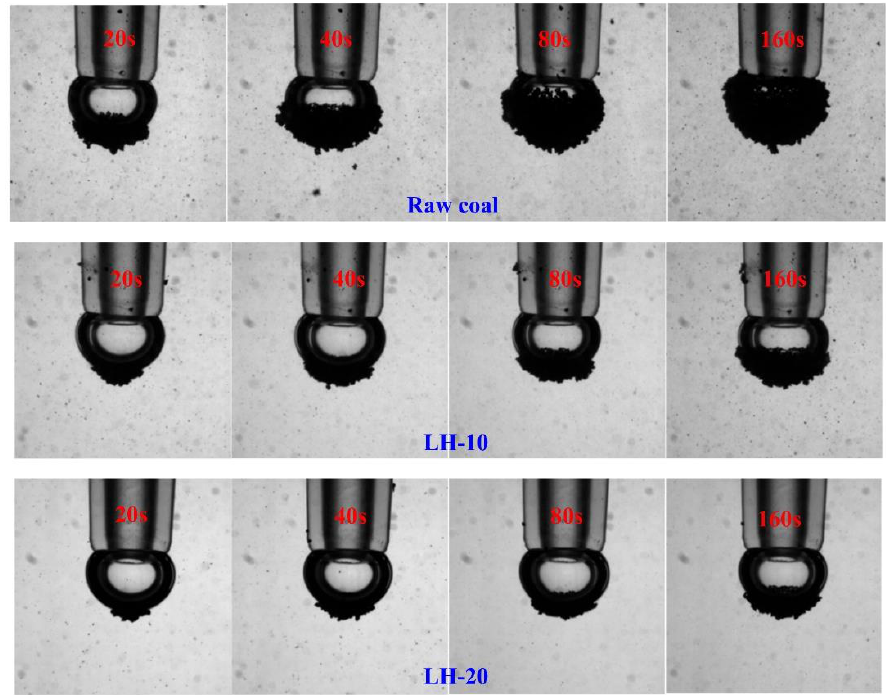
Figure 11. Bubble-particle wrap angle kinetics before and after heating oxidation at 200 °C.